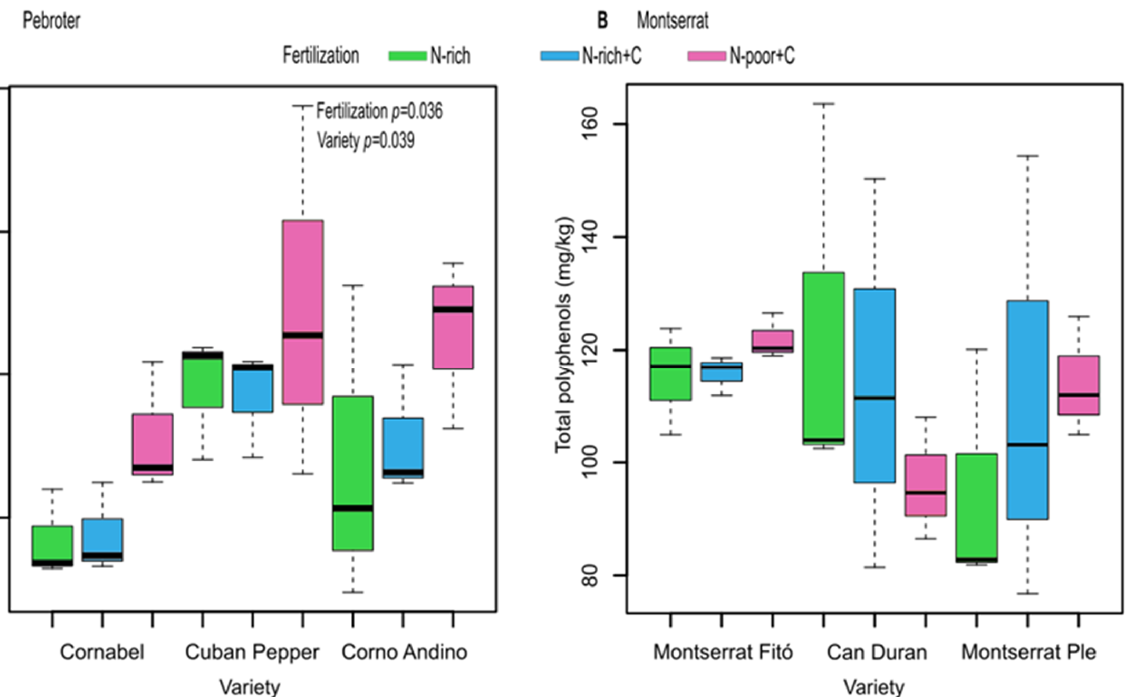
Figure 4. Total polyphenol content in tomato varieties, ( A ) Pebroter varietal group, ( B ) Montserrat varietal group.